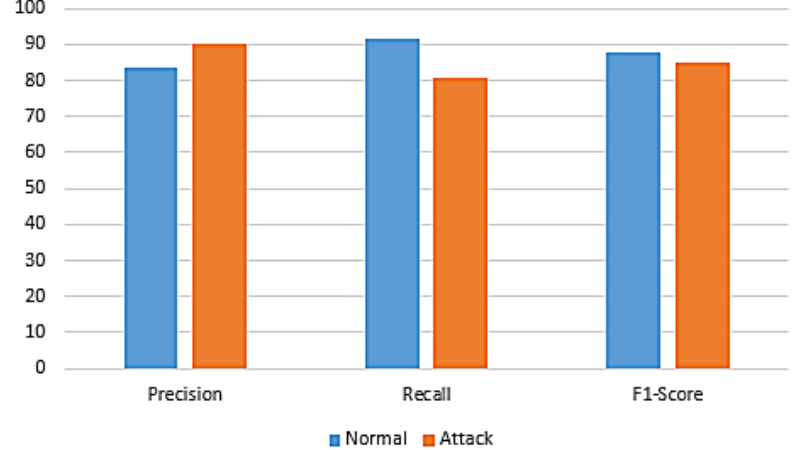
Figure 22. Naive Bayes class classification